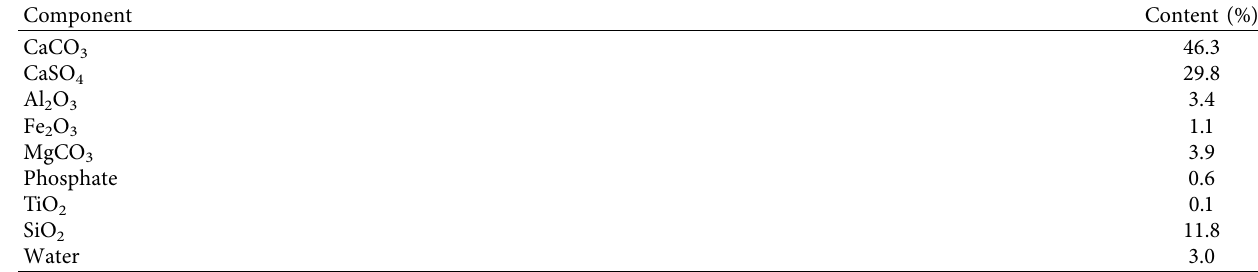
Table 11: Material composition.